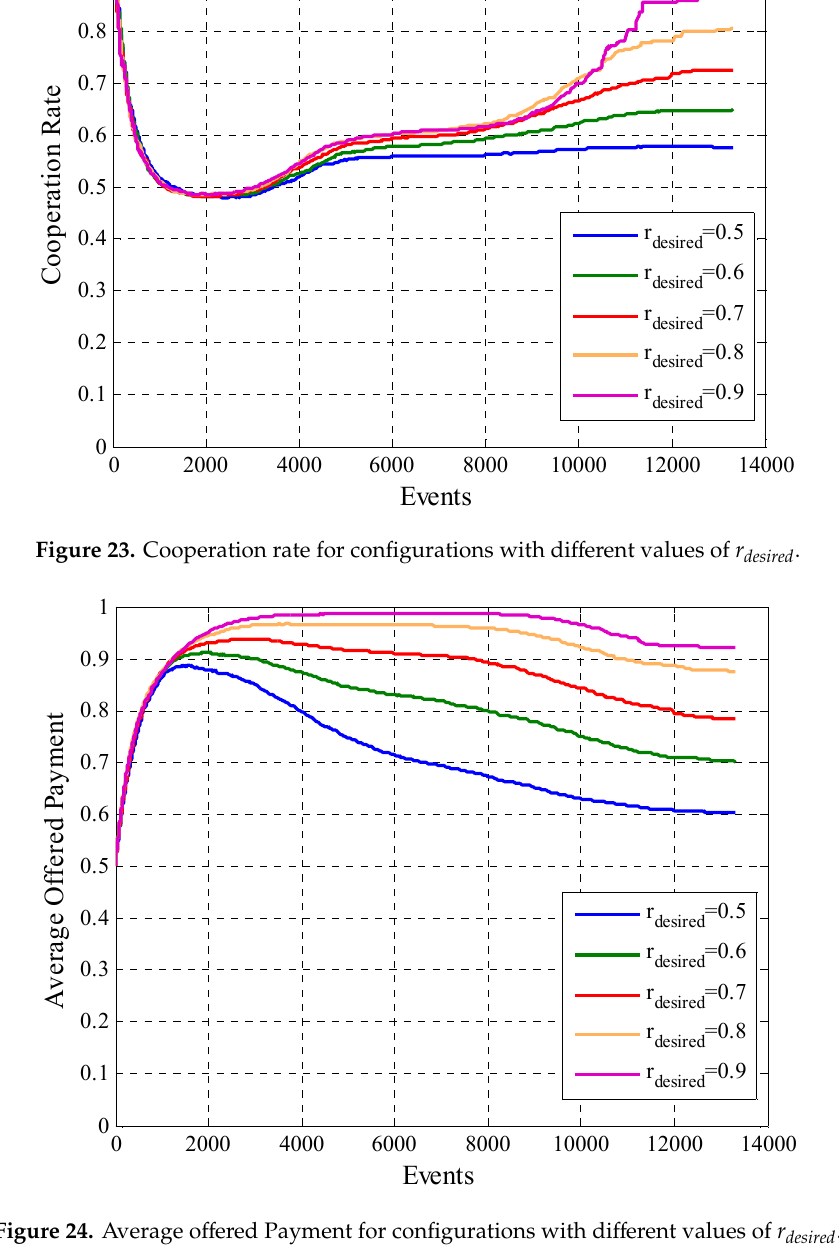
Figure 24. Average o ff ered Payment for configurations with di ff erent values of r desired . Table 2. Analysis of the number of errors in the identifications of the type of user.